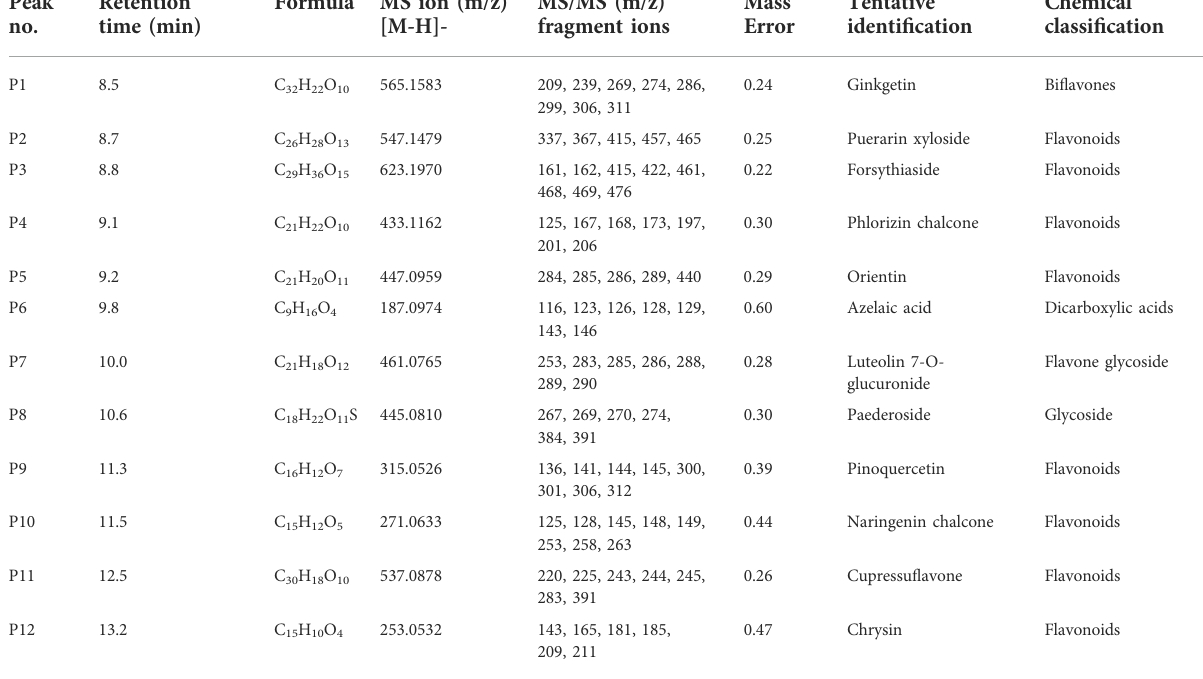
TABLE 2 LC-TOF-MS/MS data-negative ion mode for tentative compounds identi fi cation in Oroxylum indicum leaf extract. Peak